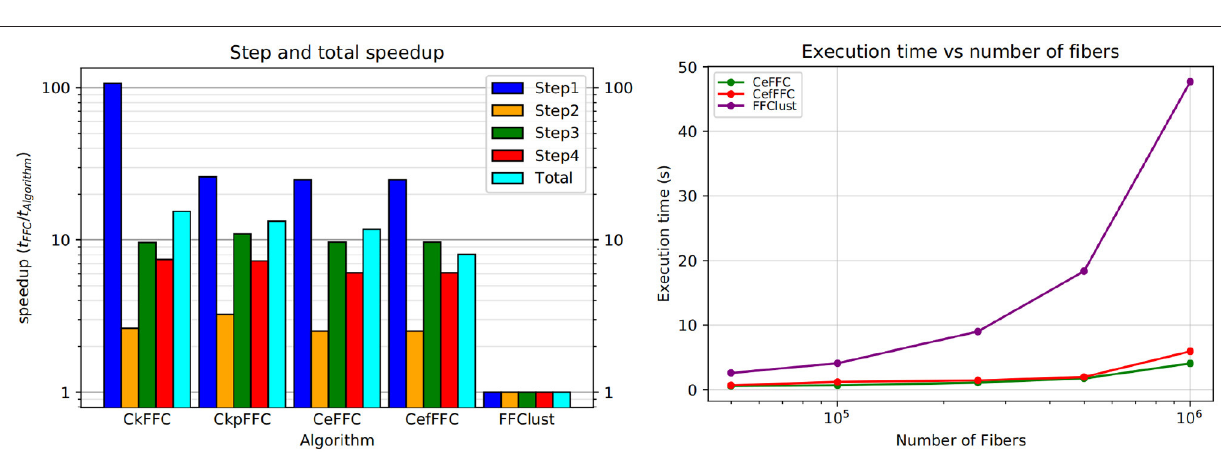
FIGURE 9 | Speedup and scalability of our parallel alternatives of FFClust. All parallel alternatives obtain a speedup greater than two in all the steps of FFClust, where the highest speedup is achieved in the Step 1 and the lowest in Step 2. The scalability test on the right figure shows that the execution time of the parallel alternatives is rather stable with the number of fibers, whereas the execution time of FFClust increases with the number of